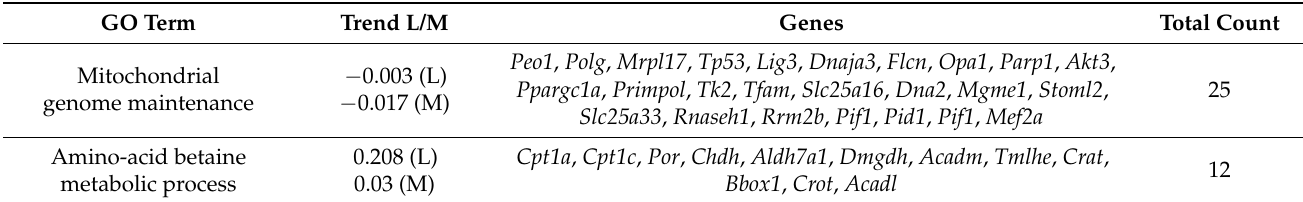
Table 1. Biological processes (GO Terms) that were significantly changed in the rat liver and skeletal muscle. Trend L/M shows decreasing (negative) or increasing (positive) expression tendency in the liver (L) and skeletal muscle (M) during the perinatal period—16th foetal day to the 4th postnatal day. Only the most important genes (25) are shown per each GO Term. (FDR ≤